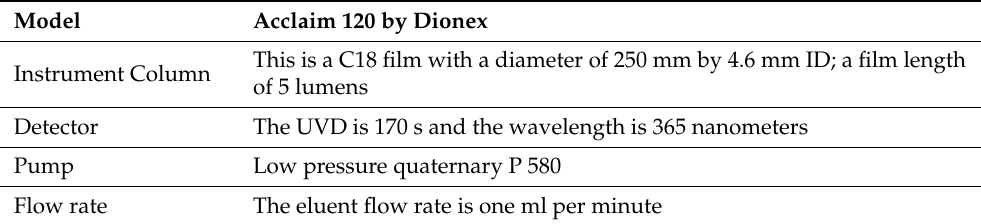
Table 5. Chemical standards reference retention time. (In acetonitrile, 15 components, each 1 mL/ampule, from aldehyde to ketone to DNPH To-11A Calibration